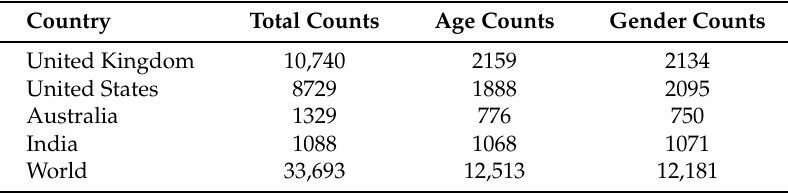
Table 2. The number of complete SARS-CoV-2 genomes with age/gender information in the United Kingdom, United States, Australia, India, and the